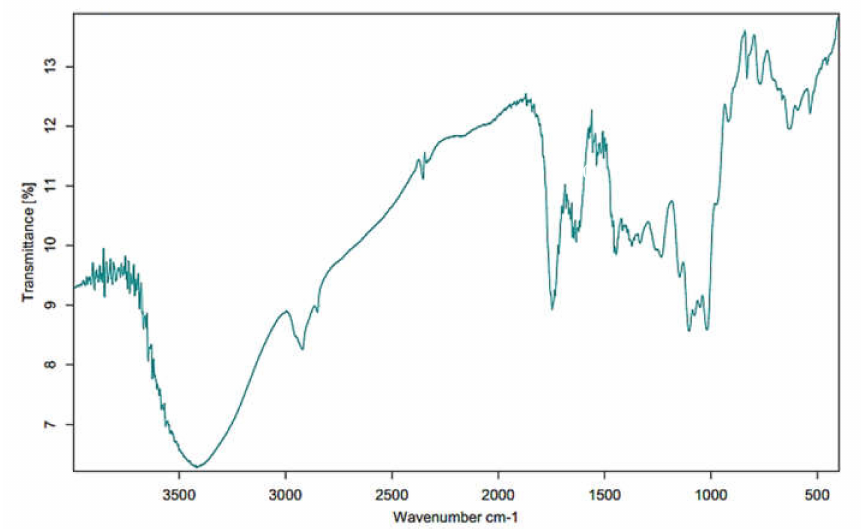
Figure 2. The FT-IR spectra of pectin extracted from Nam Dok Mai mango peel using MAE at 700 watts, from 900 to 4000 cm − 1 (x axis). %T is the percentage of transmittance (y axis).